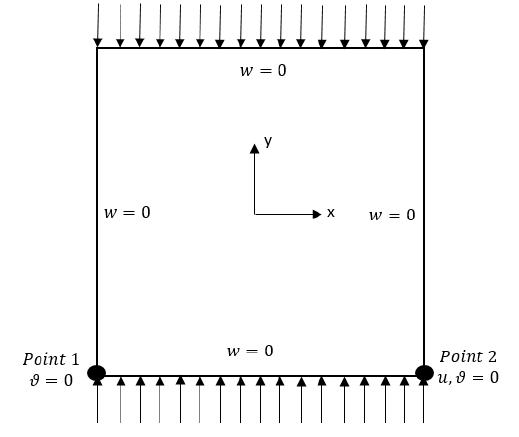
Figure 4. SSSS boundary condition of the VAT